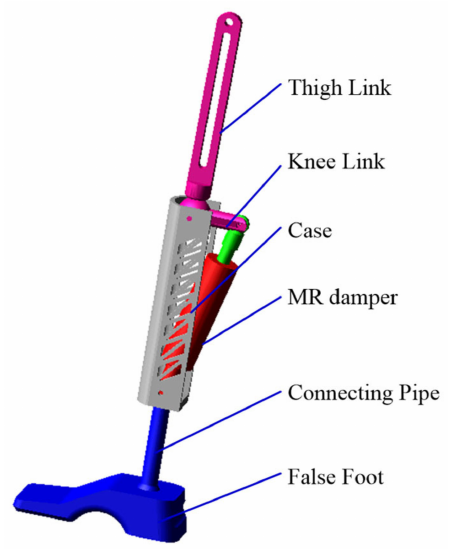
Figure 3. Three-dimensional model of MR